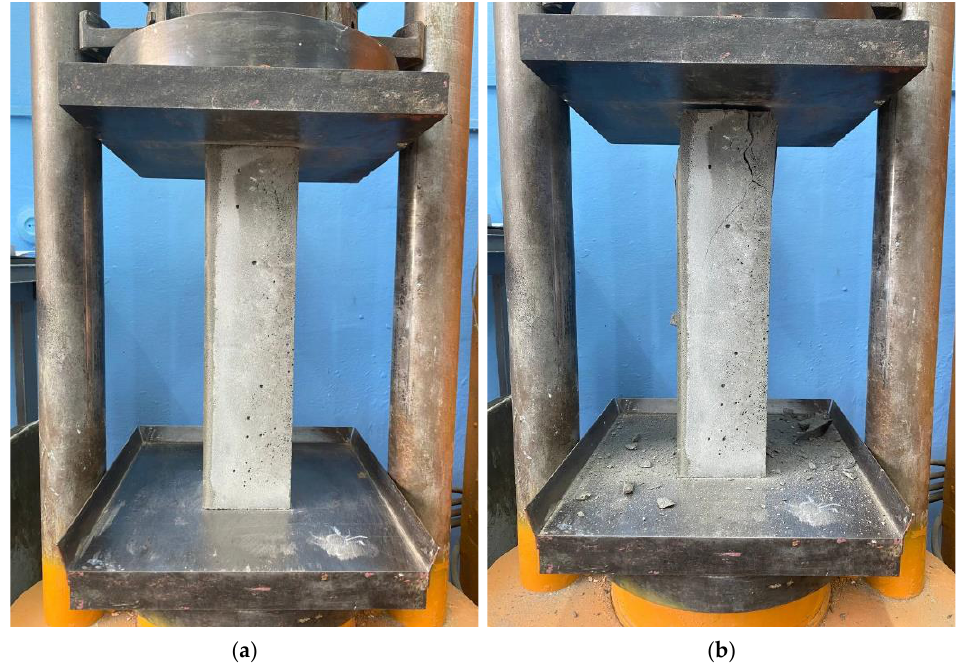
Figure 8. Axial compressive testing of concrete specimens: ( a ) initial phase of loading; ( b ) collapse phase.